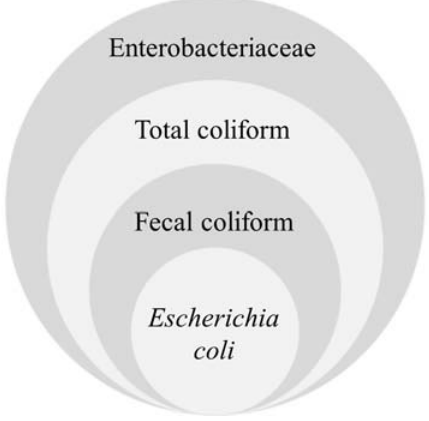
Figure 2. Relationships of coliforms and Escherichia coli